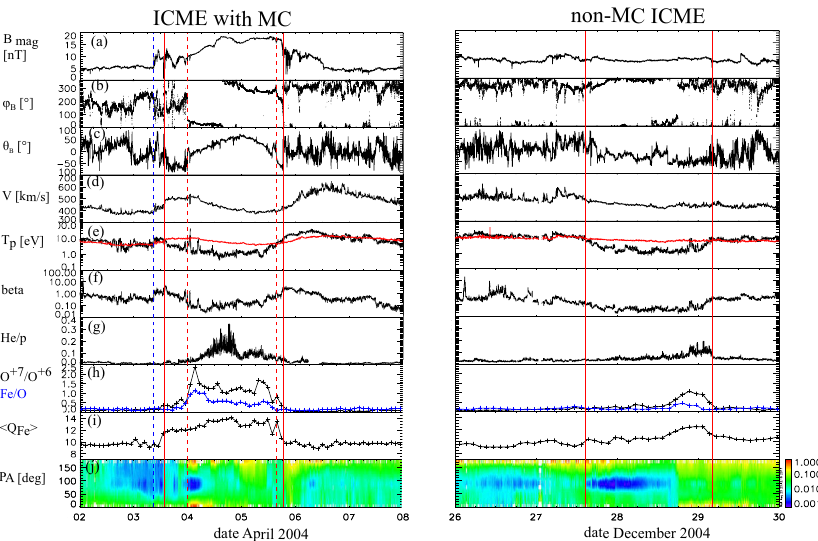
Fig. 2 (Left) An ICME with a magnetic cloud (MC) structure and (right) a non-magnetic cloud ICME. The panels show from top to bottom: a magnetic field magnitude, the b longitude and c latitude angles of the magnetic field in GSM coordinates, φ B = 90 ◦ ( φ B = 270 ◦ ) is defined eastward (westward), and θ = + 90 ◦ ( θ = − 90 ◦ ) is defined northward (southward), solar wind d speed, e proton temperature B B (black: measured temperature, red: expected temperature, see Sect. 2.1), f plasma beta, g helium to proton ratio, h O + 7 / O + 6 ratio(black)andFe/Oratio(red), i ironaveragechargestate,and j pitchanglespectrogram of 272-eV electrons. Pitch angle 0 ◦ (180 ◦ ) refers to the particles that stream parallel (anti-parallel) to the magnetic field. A pair of red solid lines bound the ICME interval and the dashed blue line shows a shock. The red dashed lines bound the interval with MC signatures. The times are from the Richardson and Cane ICME list. The measurements are from the ACE spacecraft. Data have been obtained through the ACE Data Center (http://www.srl.caltech.edu/ACE/ASC/)